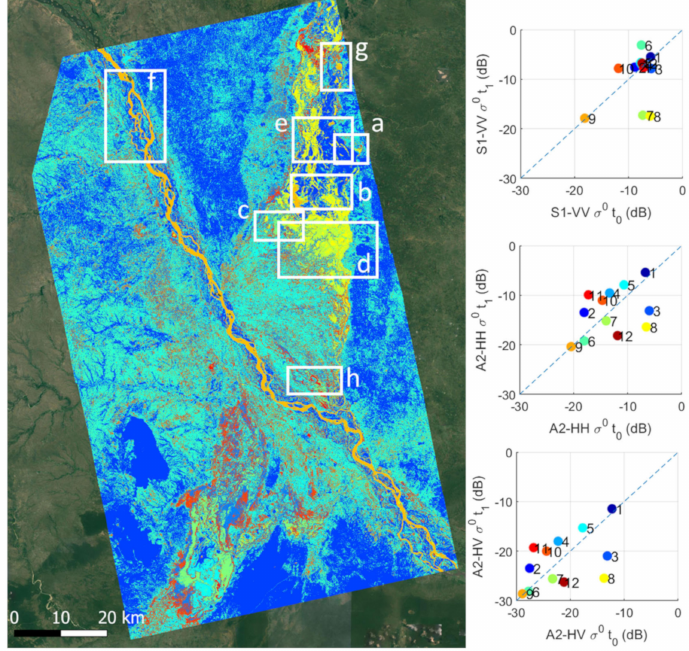
Figure 10. As in Figure 8, with K = 12 clusters. White rectangles on the left map, labeled from a to h, highlight detail areas shown enlarged in the subsequent figures.